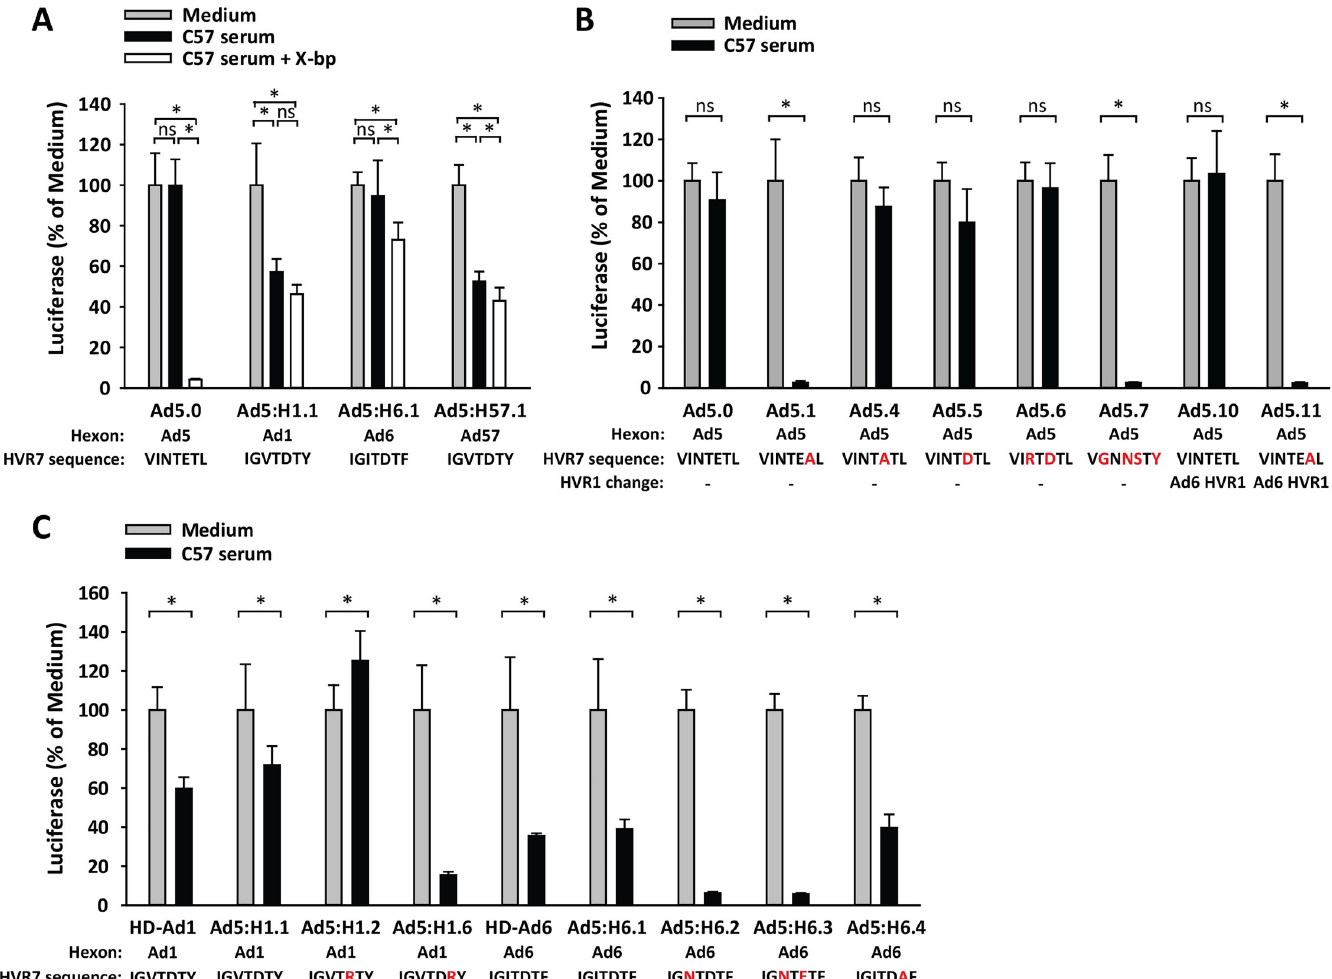
Fig 7. Neutralization of vectors by mouse serum. Ad vectors were incubated with C57BL/6 mouse serum and assessed for ability to transduce 293 cells. X-bp was added to certain samples to block FX. (A) Effect of mouse serum on an Ad5 vector (Ad5.0) as compared to Ad5 vectors with chimeric hexon from Ad1, Ad6 or Ad57. (B) Effect of mouse serum on Ad5.0 and vectors with mutations in Ad5 hexon. (C) Effect of mouse serum on HD-Ad vectors or hexon-chimeric vectors with chimeric hexon from Ad1 or Ad6. Mutated residues in HVR7 are indicated by red letters. N = 6 per group. � P � 0.05 (ANOVA and Holm-Sidak in panel A; t -test in panels B and